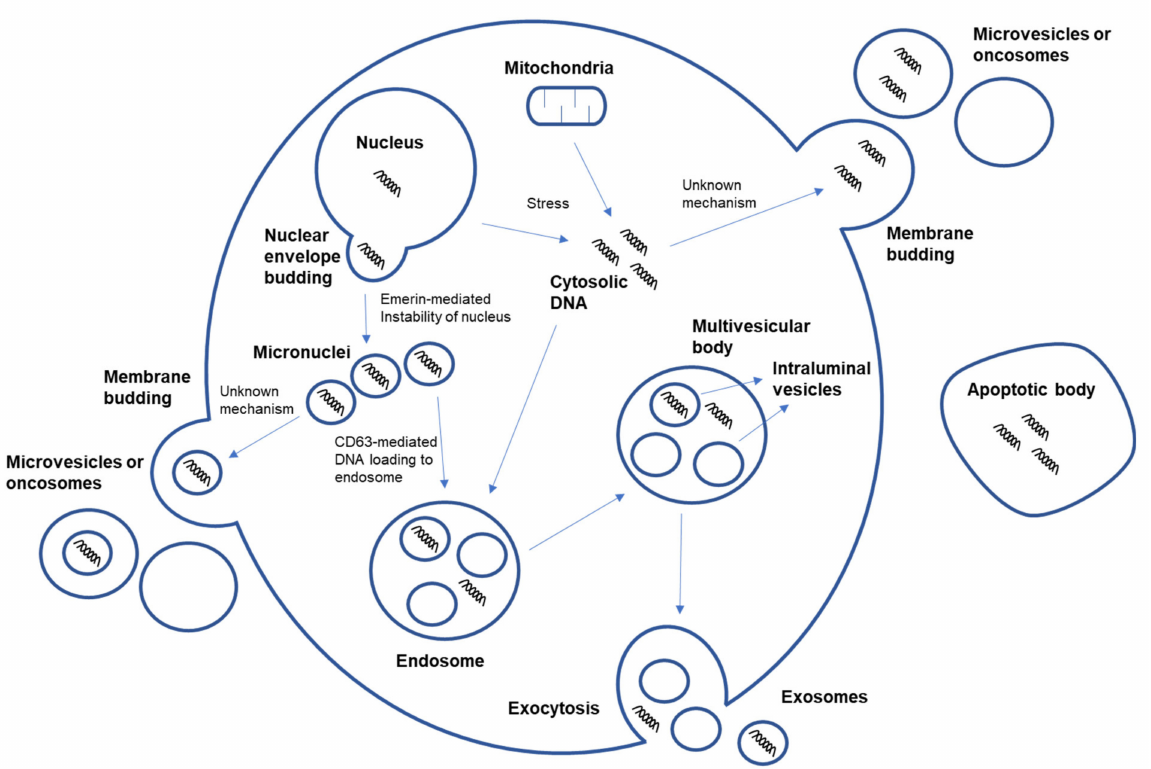
Figure 4. DNA loading into EVs via various mechanisms. DNA can be loaded into EVs through a CD63-mediated DNA shuttle or emerin-mediated nucleus instability and shedding. Other possible unknown mechanisms could include the loading of cytosolic DNA that originated from the nucleus and mitochondria by oxidative stress. EV—extracellular